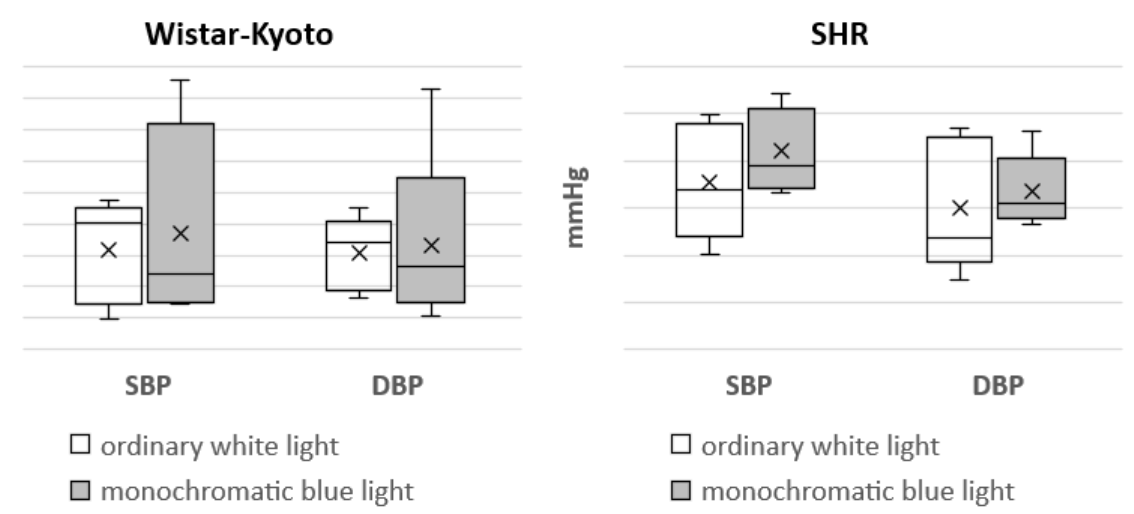
Figure 5. Amplitude of SBP and DBP in Wistar–Kyoto and SHR rats under the standard light pattern (12 h:12 h) with ordinary white light and monochromatic blue light. *— p ≤ 0.05.